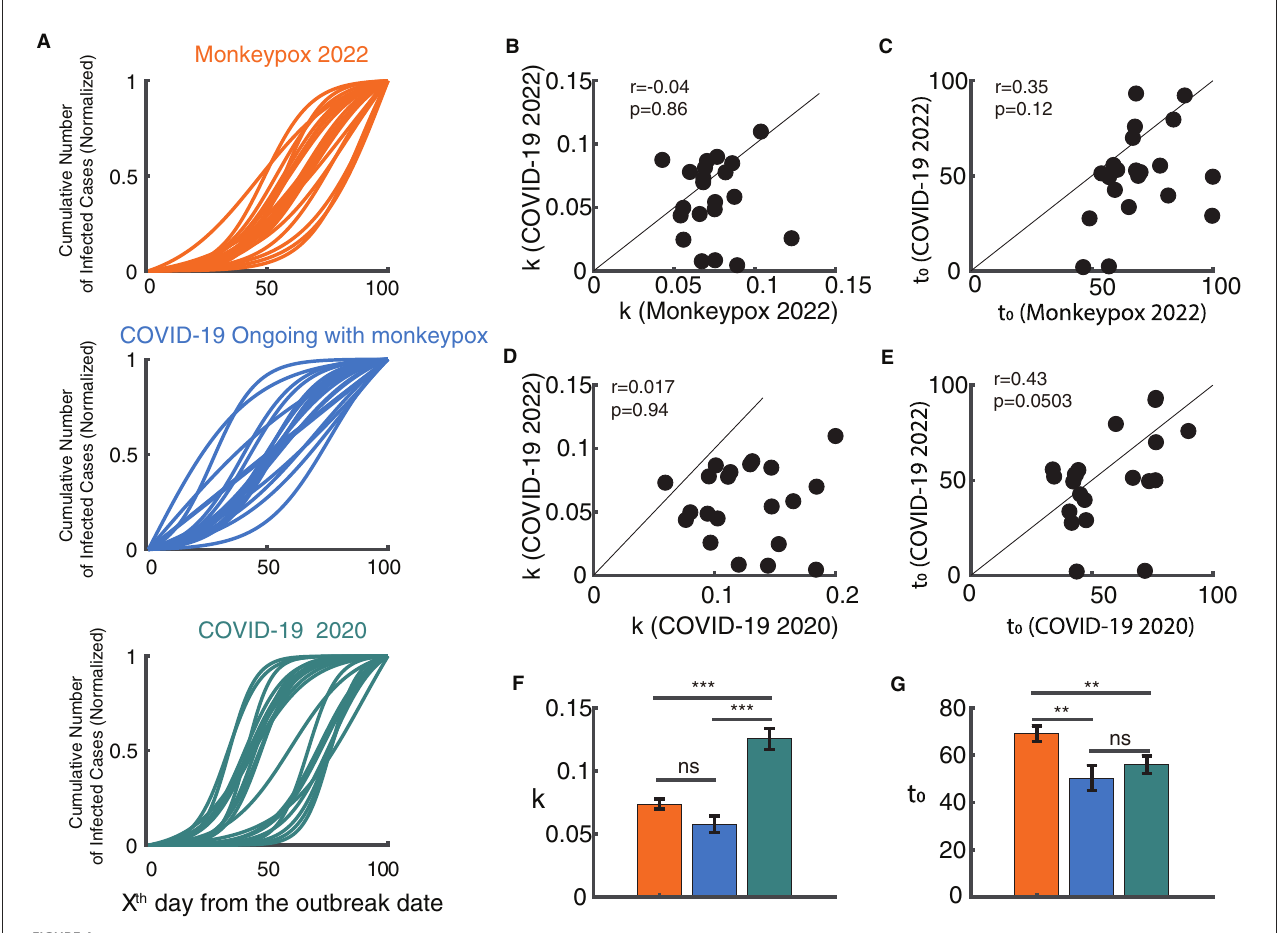
FIGURE4 Relationship between the model parameters of monkeypox and the COVID-19 epidemic. (A) Normalized fitted curves of model for 21 countries in monkeypox 2022 (blue), COVID-19 2022 (orange) and COVID-19 2020 (green). (B, C) Relationship between growth rate (k) and semi-saturation period (t 0 ) between monkeypox and COVID-19 in 2022. (D, E) Relationship between growth rate (k) and semi-saturation period (t 0 ) between COVID-19 in 2020 and COVID-19 in 2022. (F, G) Comparison of the values of growth rate (k) and semi-saturation period (t 0 ) between monkeypox and COVID-19 in both